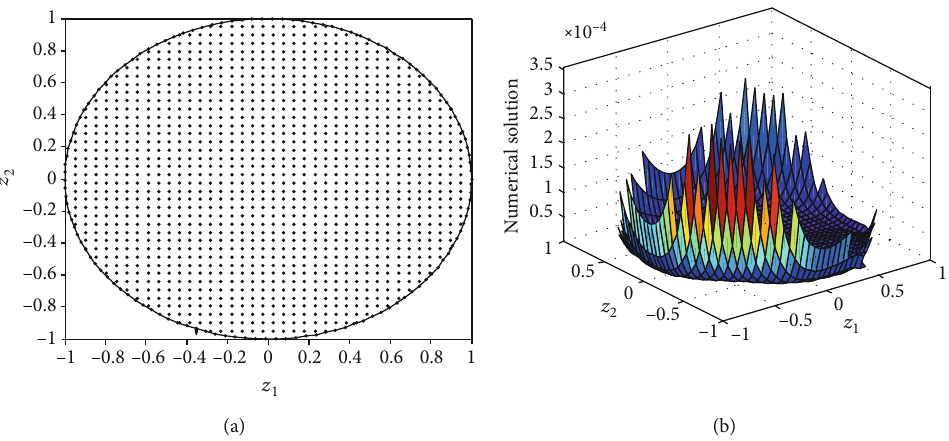
Figure 14: (a) Irregular domain and (b) absolute error for Problem